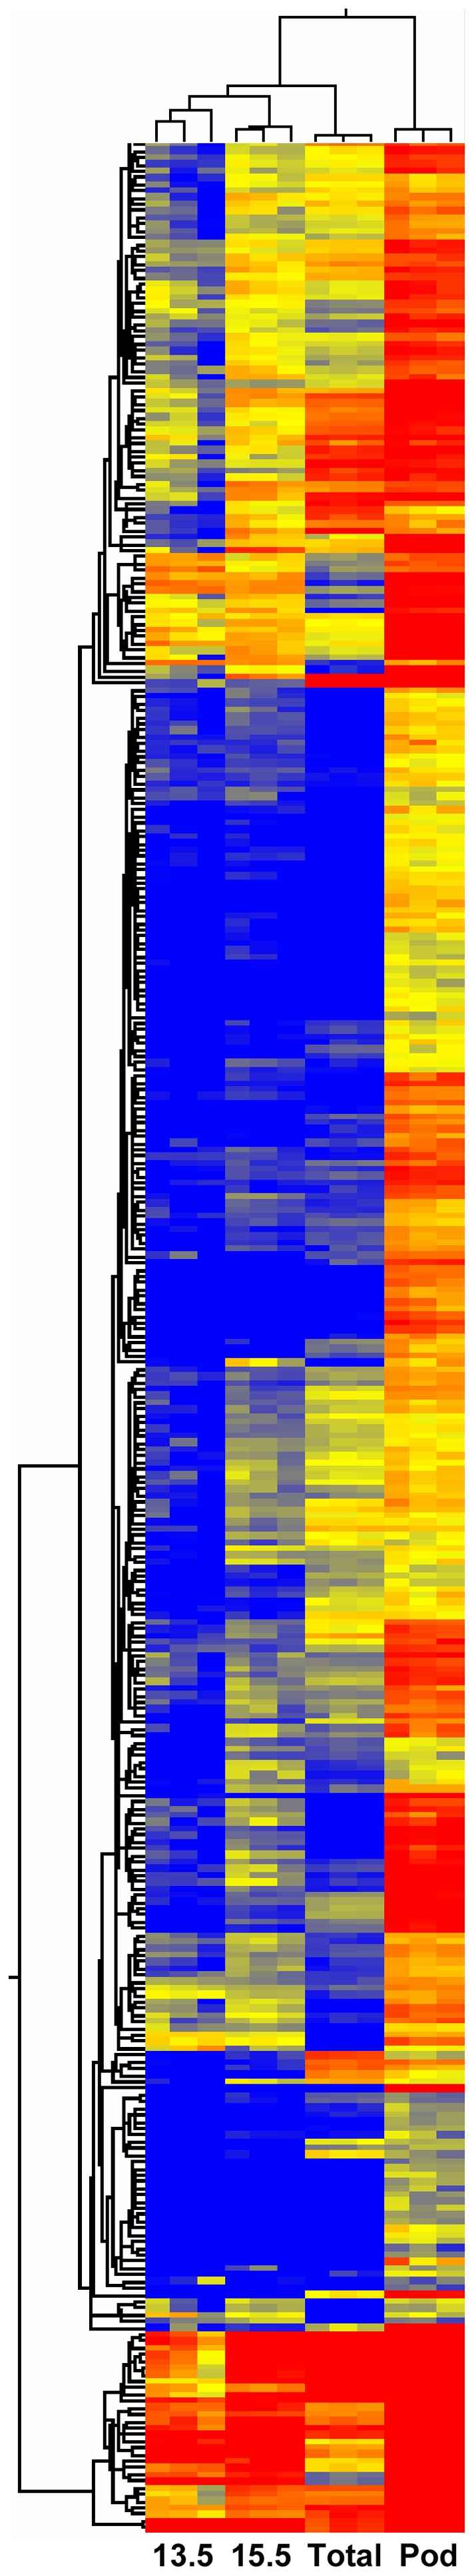
Heatmap of 365 probesets with five fold elevated expression in adult podocytes.A relatively stringent screen, requiring five fold enrichment in adult podocytes (Pod) compared to either total adult kidney cortex (Total), or E13.5 embryonic podocytes (13.5). Red indicates strong expression and blue weak expression.